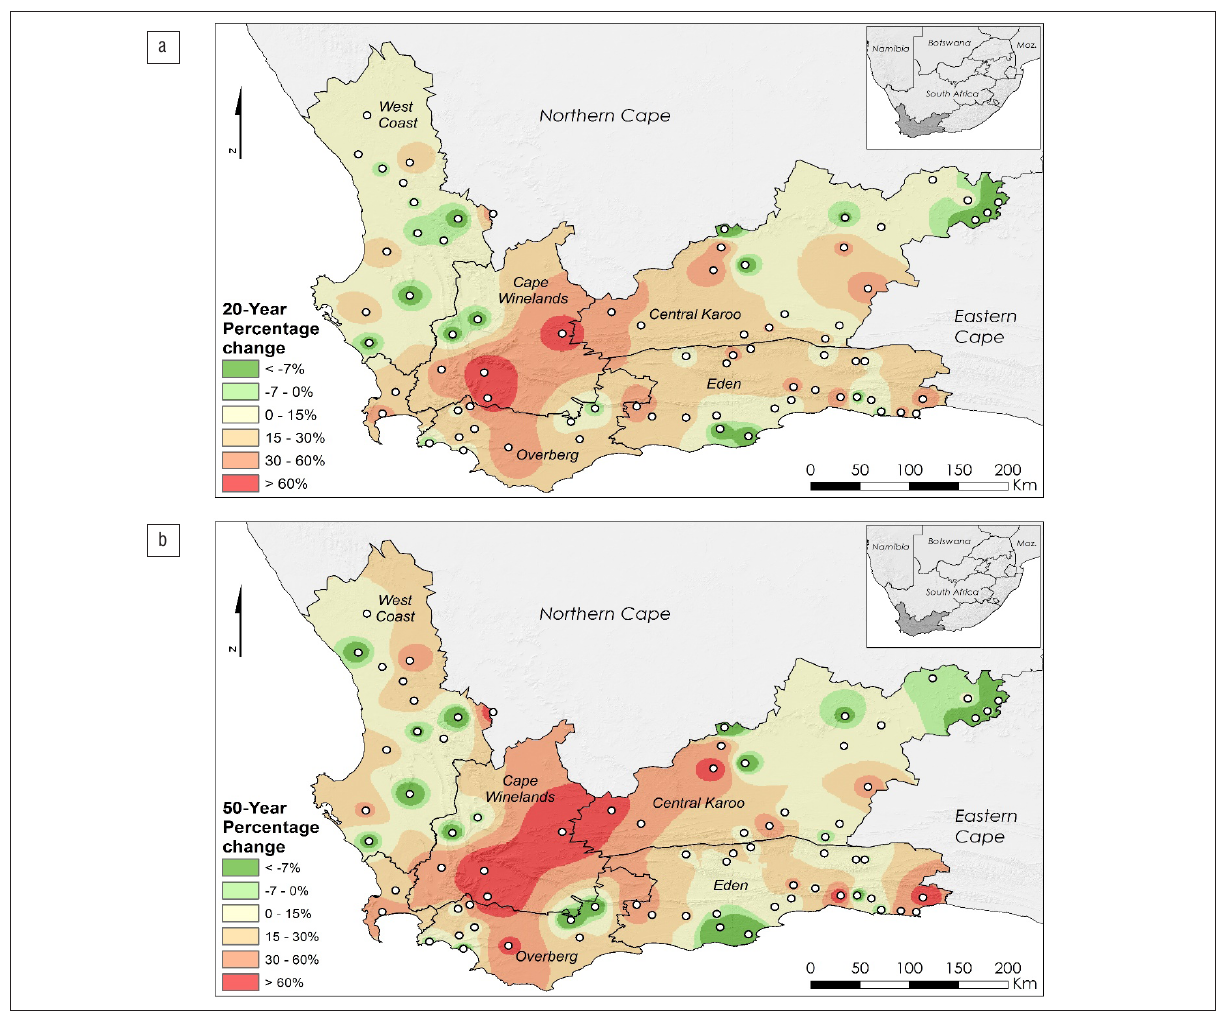
Figure 5: Inverse-distance-weighted interpolations of (a) 20-year and (b) 50-year 1-day return period rainfall changes (%) above the 98th percentile threshold for the Western Cape from 1950–1979 to The green areas in Figure 4 represent areas of coherent decreases in 20- and 50-year return period rainfalls, while other areas (beige to red) are areas of coherent increases. Two separate regions stand out as areas of coherent decreases: the western mountain escarpment of the West Coast District Municipality (Cederberg to Kouebokkeveld Local Municipalities) and the Central Karoo District Municipality. Most of the remaining parts of the province show increases in the 20- and 50-year rainfalls in the second period, particularly in the mountainous regions of the southern Cape Winelands District Municipality (Drakenstein to Breede Valley local municipalities), and suggest a strong increase in the intensity of extreme return period rainfalls, which potentially enhances their flood risk substantially. There are three pairs of rainfall stations close together in which the pairs show opposing signs of change. Either the data quality of these stations should be questioned, or they are subject to more local-scale influences on rainfall intensity than are the others. Spatial techniques (such as interpolation) are therefore possibly useful for assessing the data quality of these stations by highlighting stations that are different from the general local trend of other nearby gauges. The results produced using the 98th percentile as the GPD threshold show an expectedly similar pattern to that of the 95th percentile.